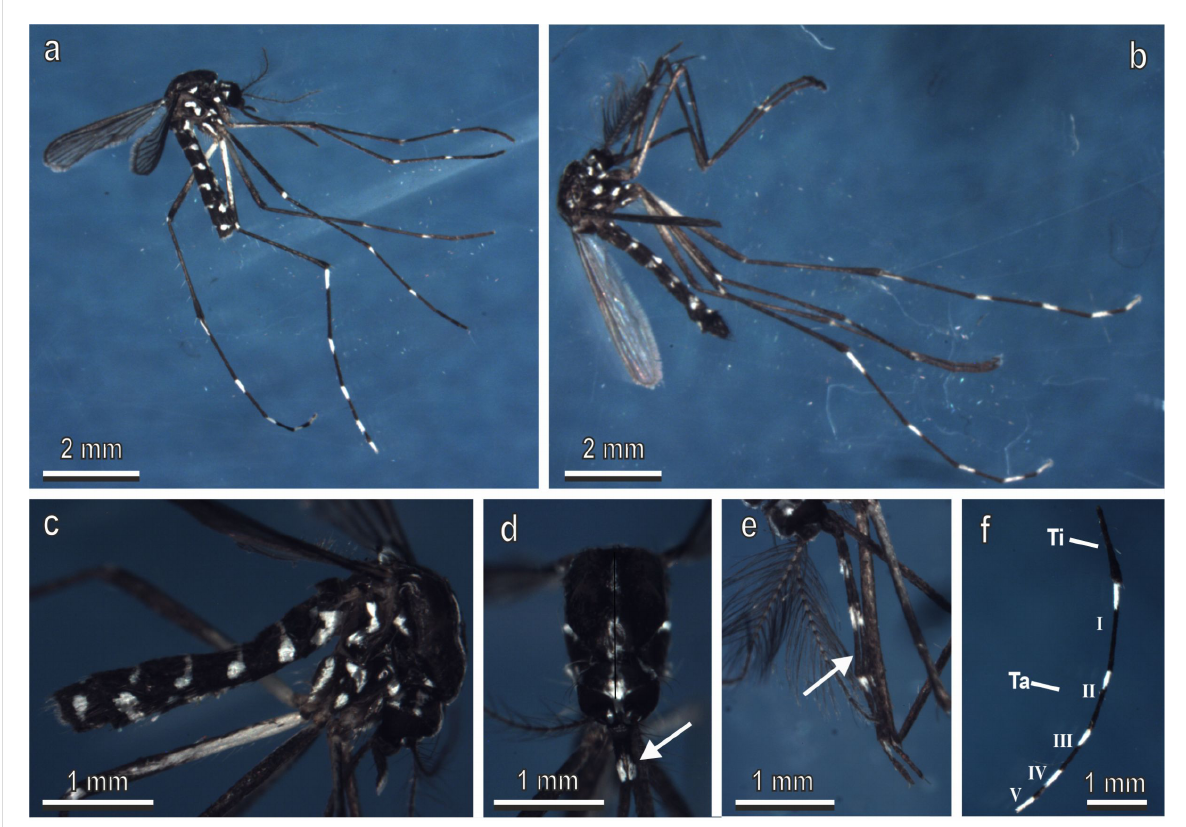
Figure 1: Adults of Aedes albopictus under a stereomicroscope. Female (a) and male (b) typically characterised by the presence of white and black areas on their body. (c) Detail of the abdomen and thorax of the female. (d) Detail of the head and maxillary palps (arrow) of a female. (e) Detail of the maxillary palp (arrow) of a male. (f) Detail of the tarsi (Ta) of the hindlegs of the female. Note that each segment is white in its proximal portion and black in its distal portion except the last segment which is totally white. Ti, tibia.